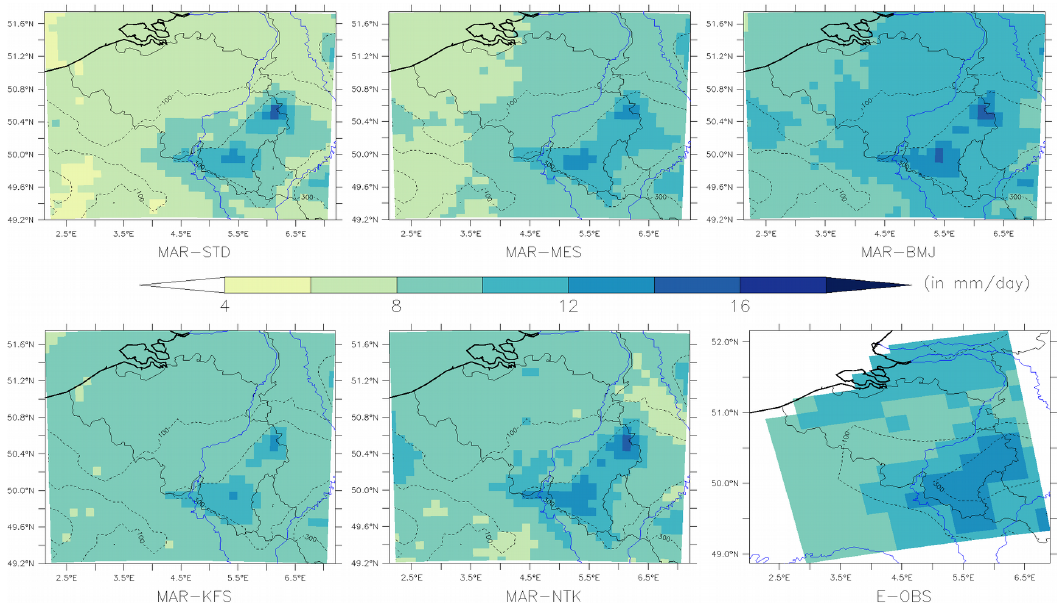
Figure 9. Idem as Figure 4 but for the 95th percentile of daily precipitation in mm/day.